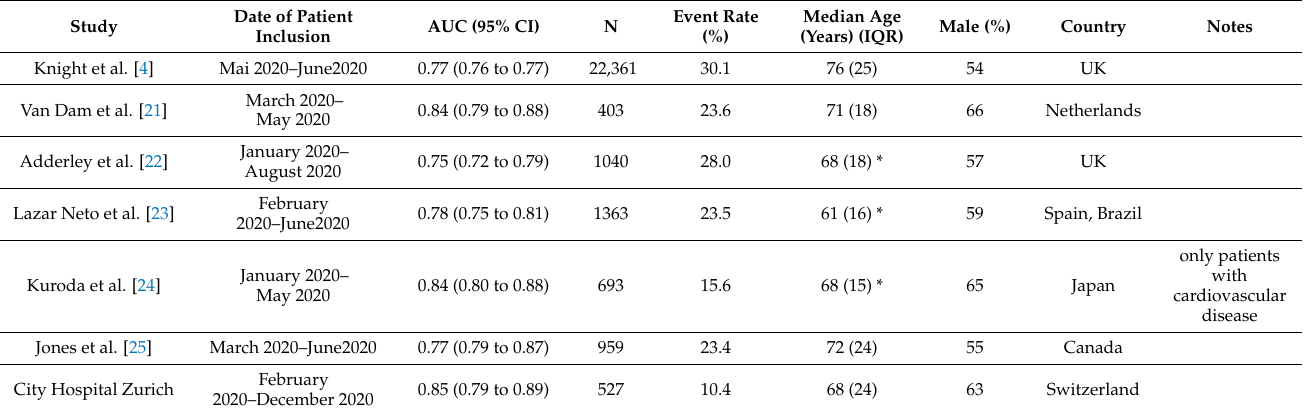
Table 6. Mortality Score validation performance compared to original